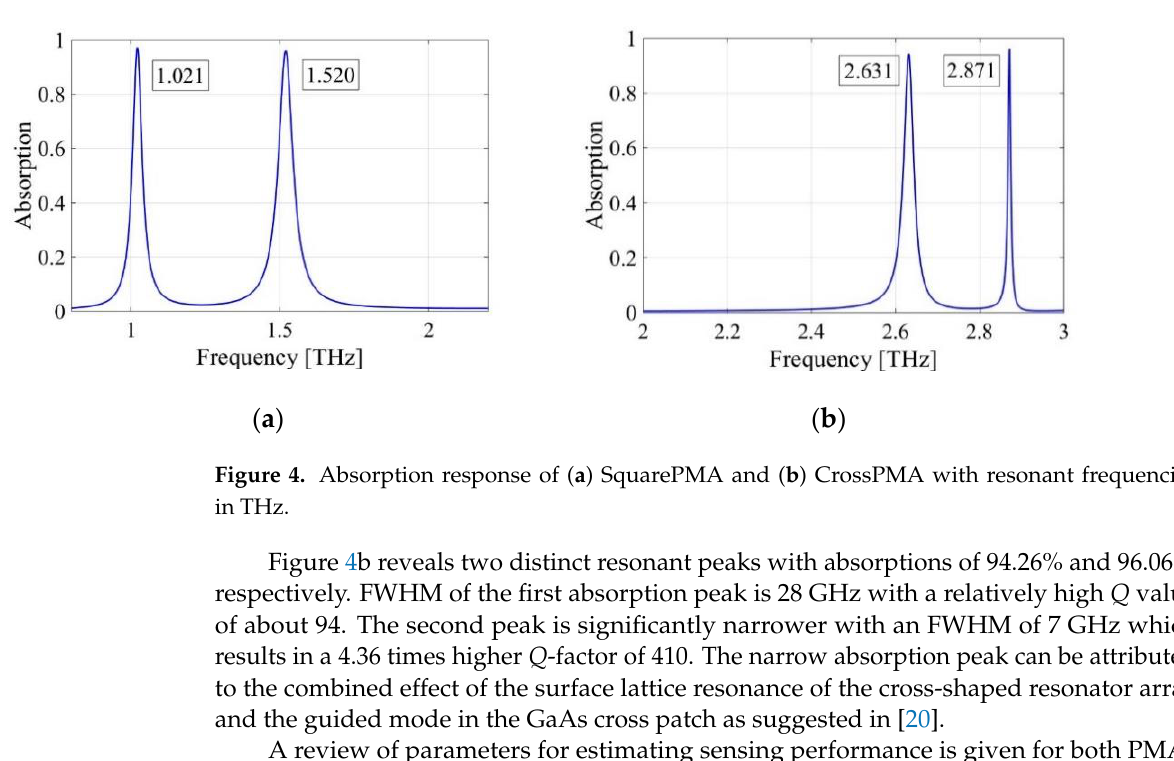
Table 2. Comparison of sensing performance.